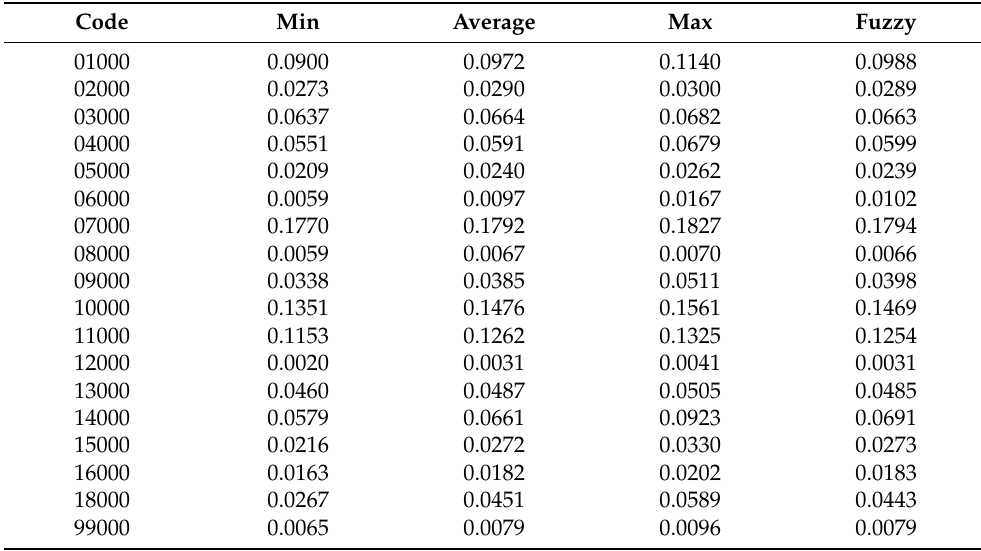
Table A3. The second step of fuzzification of the flags of the ships deficiency data in Tokyo MoU.